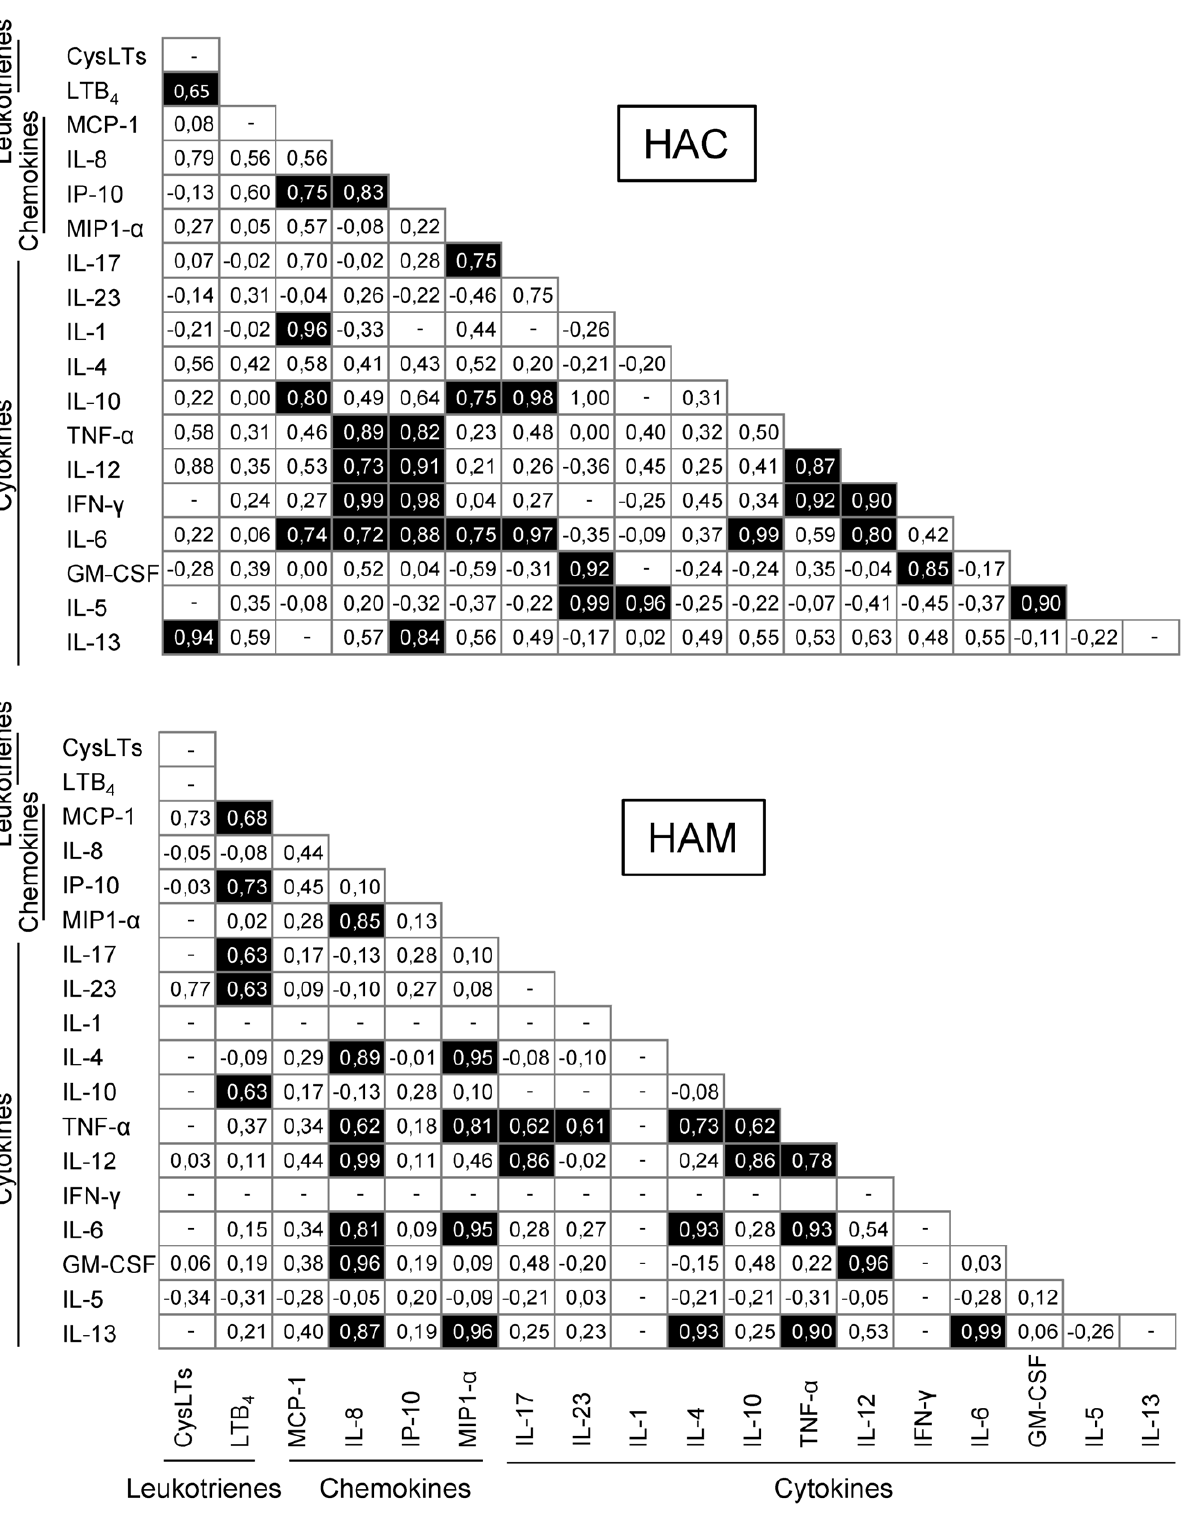
Figure 5. Correlation of plasma biomarkers in HTLV-1 infection. Samples from HTLV-1-infected subjects were used to detect leukotrienes, chemokines and cytokines by ELISA. A correlation analysis was performed to analyze biomarkers levels. The results of a non-parametric Spearman’s test and ‘ r’ index are provided in the figure. Filled squares indicate positive correlations. HAC – HTLV-1 asymptomatic carriers; HAM – HAM/TSP subjects.